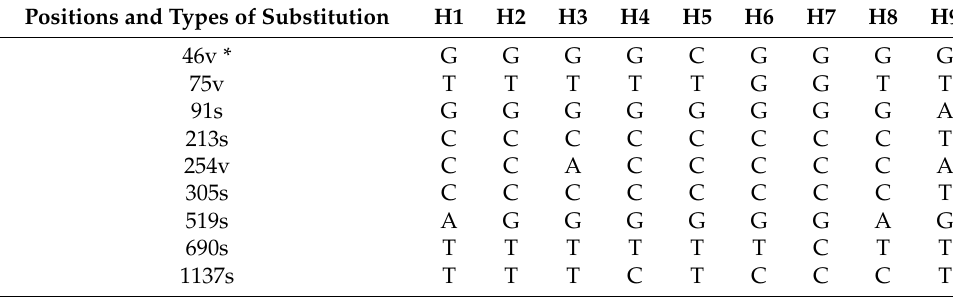
Table 2. Positions and types of nucleotide substitution in the nine RAD23 haplotypes (H1-9) of Phytophthora infestans sampled from seven fields in